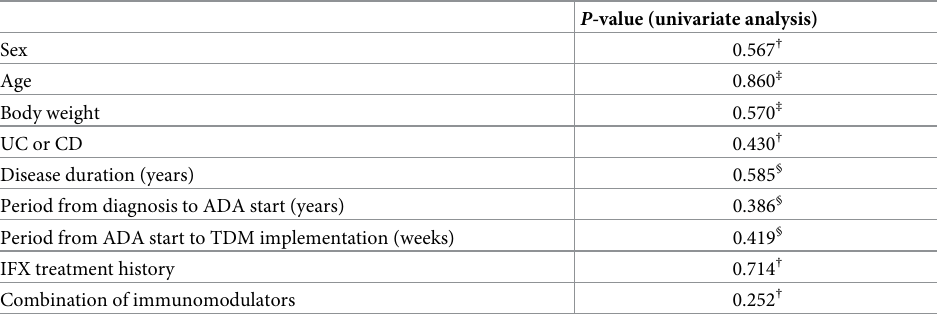
Table 2. Factors influencing blood ADA